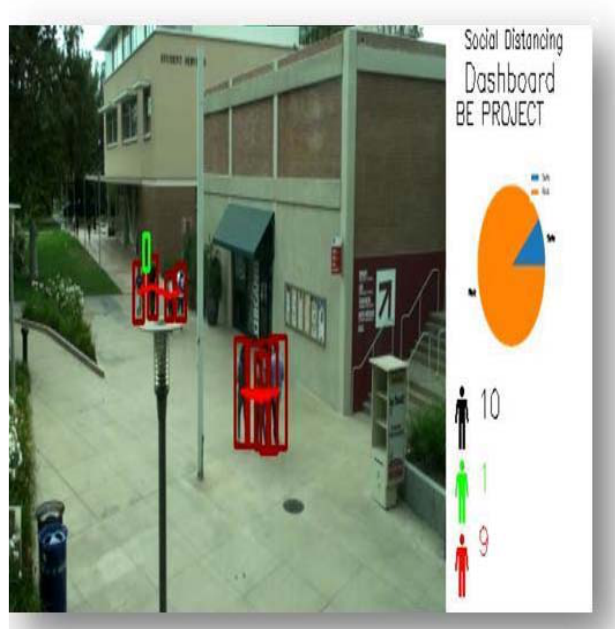
Fig 5.2: Social distancing violations > Threshold